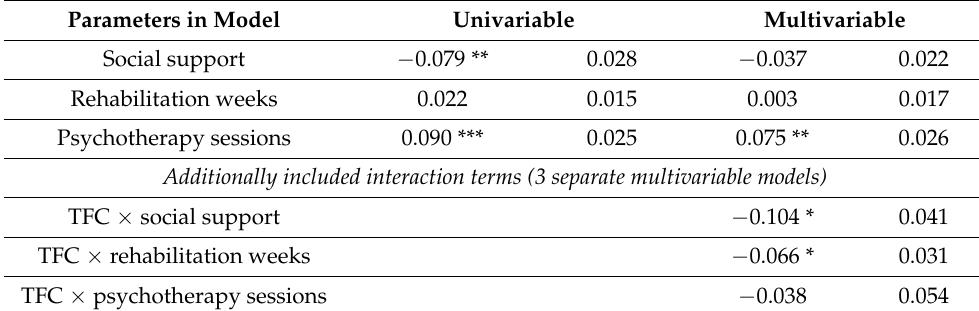
Table 2. Cont . Parameters in